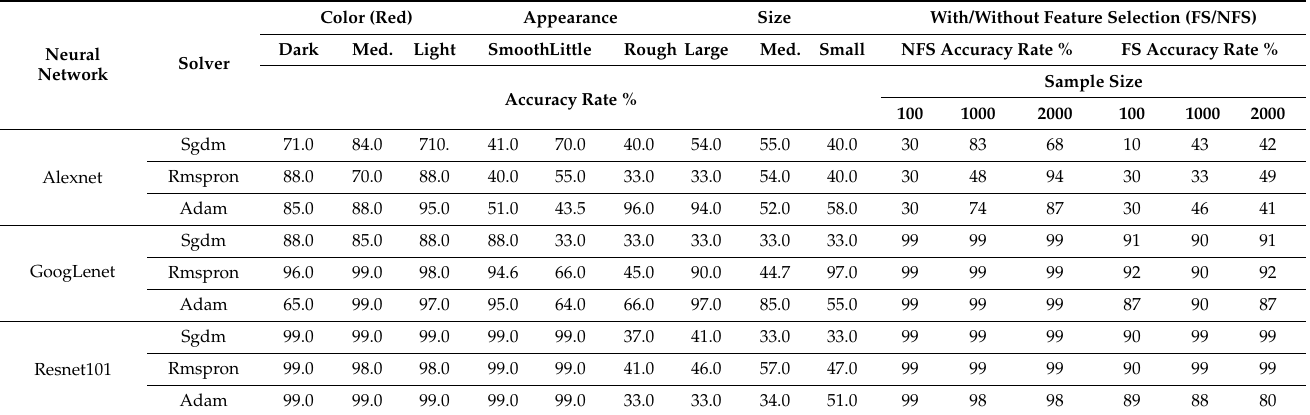
Table 5. Total accuracy rate outcomes for training from the three NN frameworks.